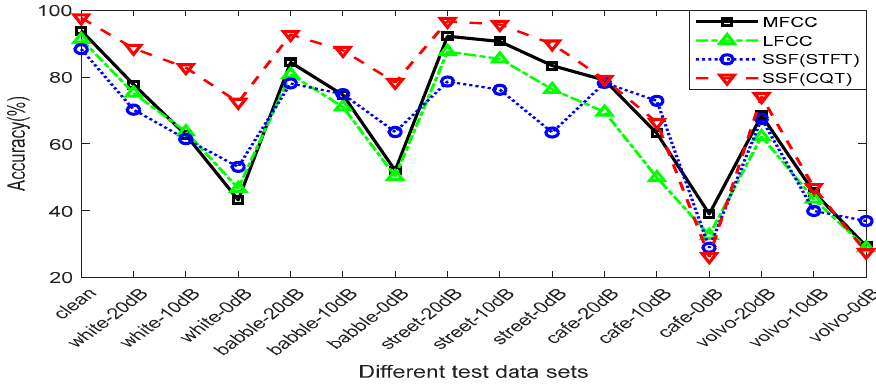
Figure 8. Comparison of accuracy of different features under SVM.